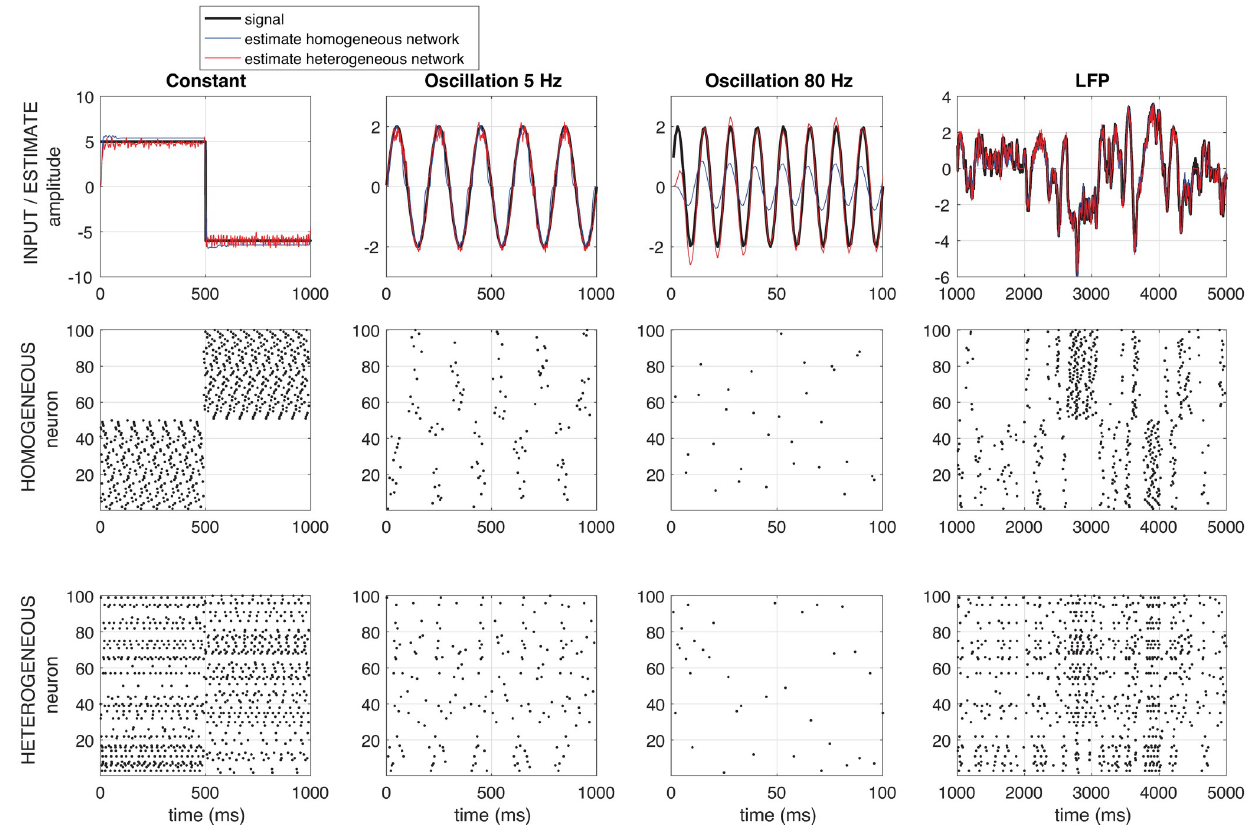
Fig 2. Example network response. Example of the response of a homogeneous (red) and a heterogeneous (blue) network to a constant input (first column), to a low frequency input (5 Hz, second colum), to a high frequency input (80 Hz, third column) and to a recorded LFP-signal (right). The homogeneous network consists of 50 neurons with a positive representing filter g and 50 neurons with a negative one (see section ‘Derivation of a filter- network that performs stimulus estimation); the heterogeneous network consists of 100 neurons with each a different (but normalized) representing filter g . Network parameters: Δ = 7, 5 ms, ν = μ = 0.5. No noise is added to this network.